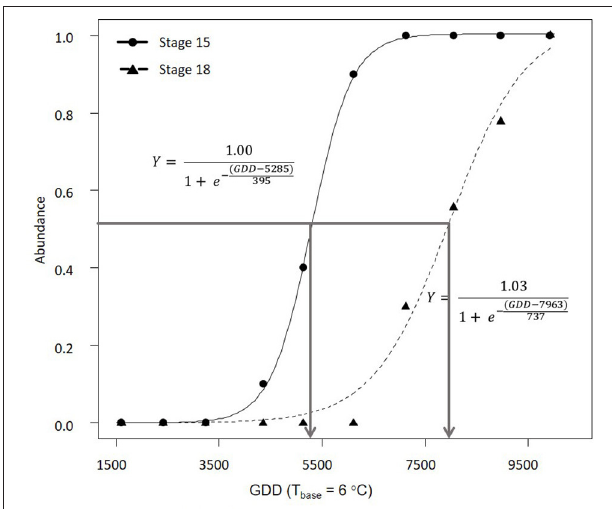
FIGURE 2 | Progression of 2-year-old Miscanthus × giganteus through BBCH developmental stages 15 and 18 in 2016. The horizontal line indicates 50% of stems at certain stage or higher and the arrows indicate the estimated onset date for each stage. Logistic equation for each progression is also presented.